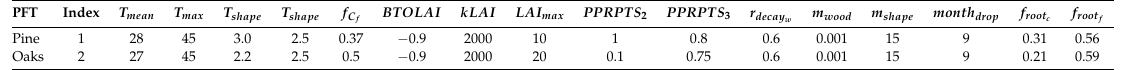
Table A27. Functional group